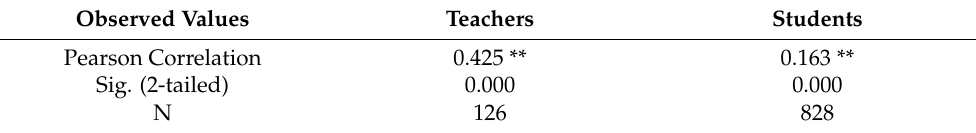
Note: **. Correlation is significant at the 0.01 level